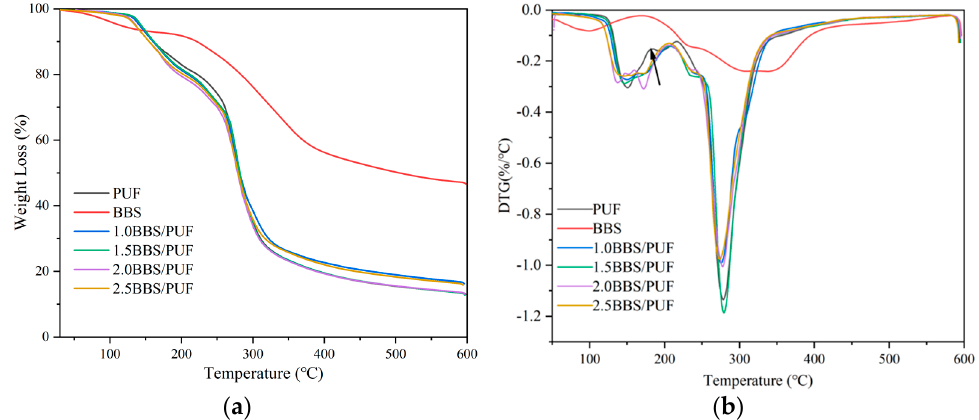
Figure 3. Thermogravimetric ( a ) and derivative thermogravimetric ( b ) curves of BBS, PUF resin, and BBS ‐ modified PUF resins with different BBS additions.